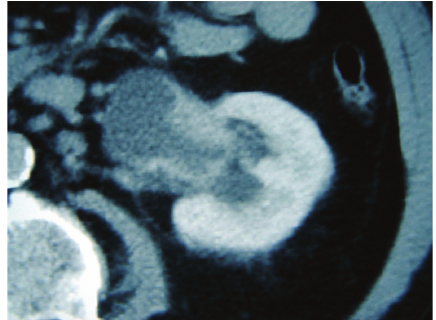
Figure 2: Computed tomography scan showing marked focal thick- ening of the wall of the inferior aspect of the left renal pelvis extending into the lower pole calyx and into the pelviureteric junction resulting in left